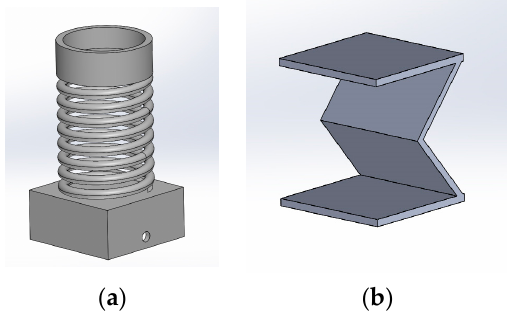
Figure 4. Two different designs for the permanent magnet supports: ( a ) First design; ( b ) Second design.